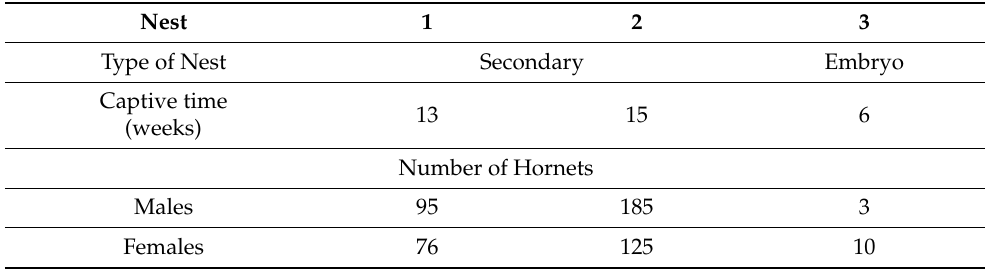
Table 2. Number of hornets counted in each nest after captive breeding in the Figure 11. Vespa velutina male hornets in the nest.